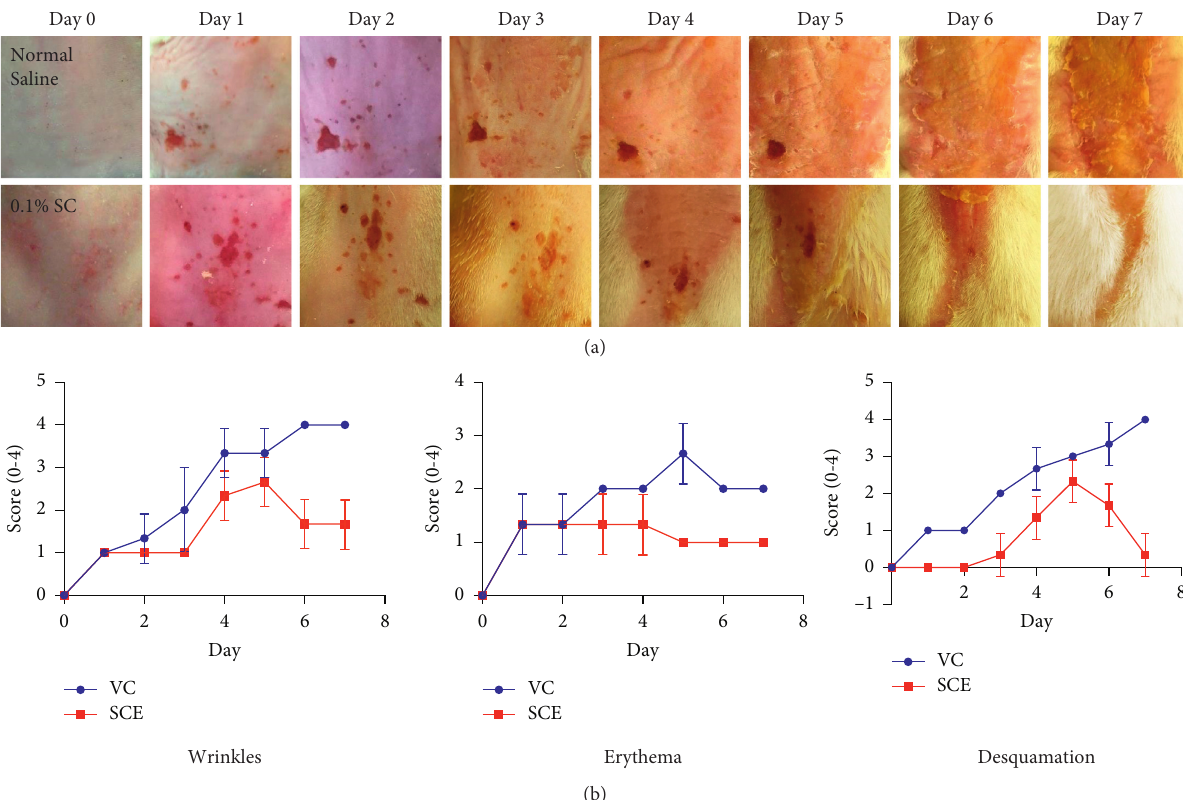
Figure 3: Pathological changes of the mice dorsal skin area after 2 h/day UV-A irradiation for 1 week. (a) The photo observations of the dorsal skins. Image records were taken of the dorsal skin area every day after 1 hour UV-A irradiation. (b) The graph showing wrinkles scoring. (c) The graph showing erythema scoring. (d) The graph showing desquamation scoring. Erythema and desquamation (scaling) scoring from 1–4 were conducted based on the Psoriasis Area Severity Index